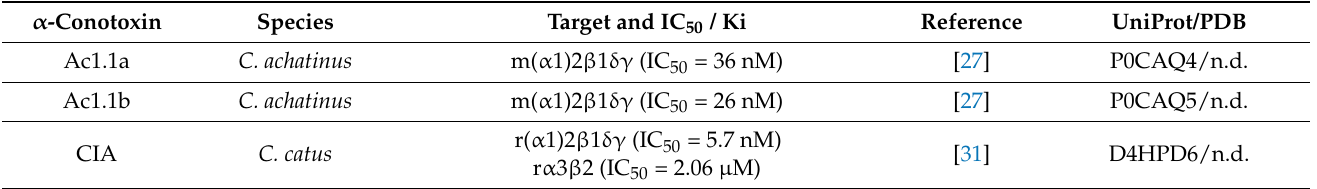
Table 1. The α -conotoxins mentioned in the main text are shown, together with their targets and potencies. α -Conotoxin Species Target and IC 50 /